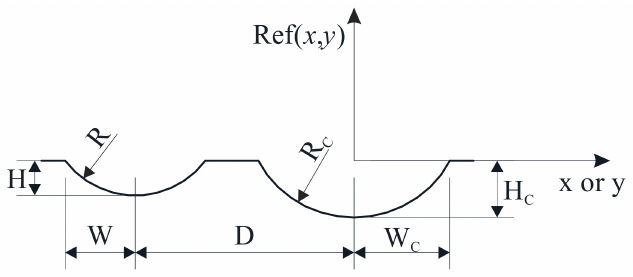
Figure 7. Dimensions of the reference